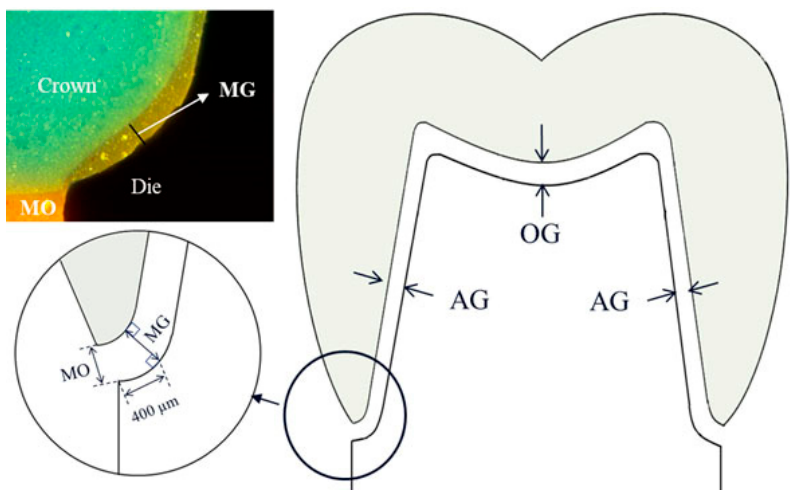
Figure 2. Diagram for measurement locations of MO (marginal opening), MG (marginal gap), AG (axial gap), OG (occlusal gap), and silicone replica.